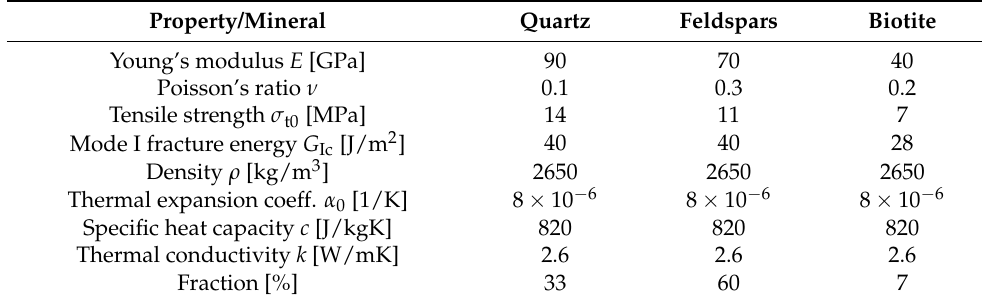
Table 1. Material properties for simulations.